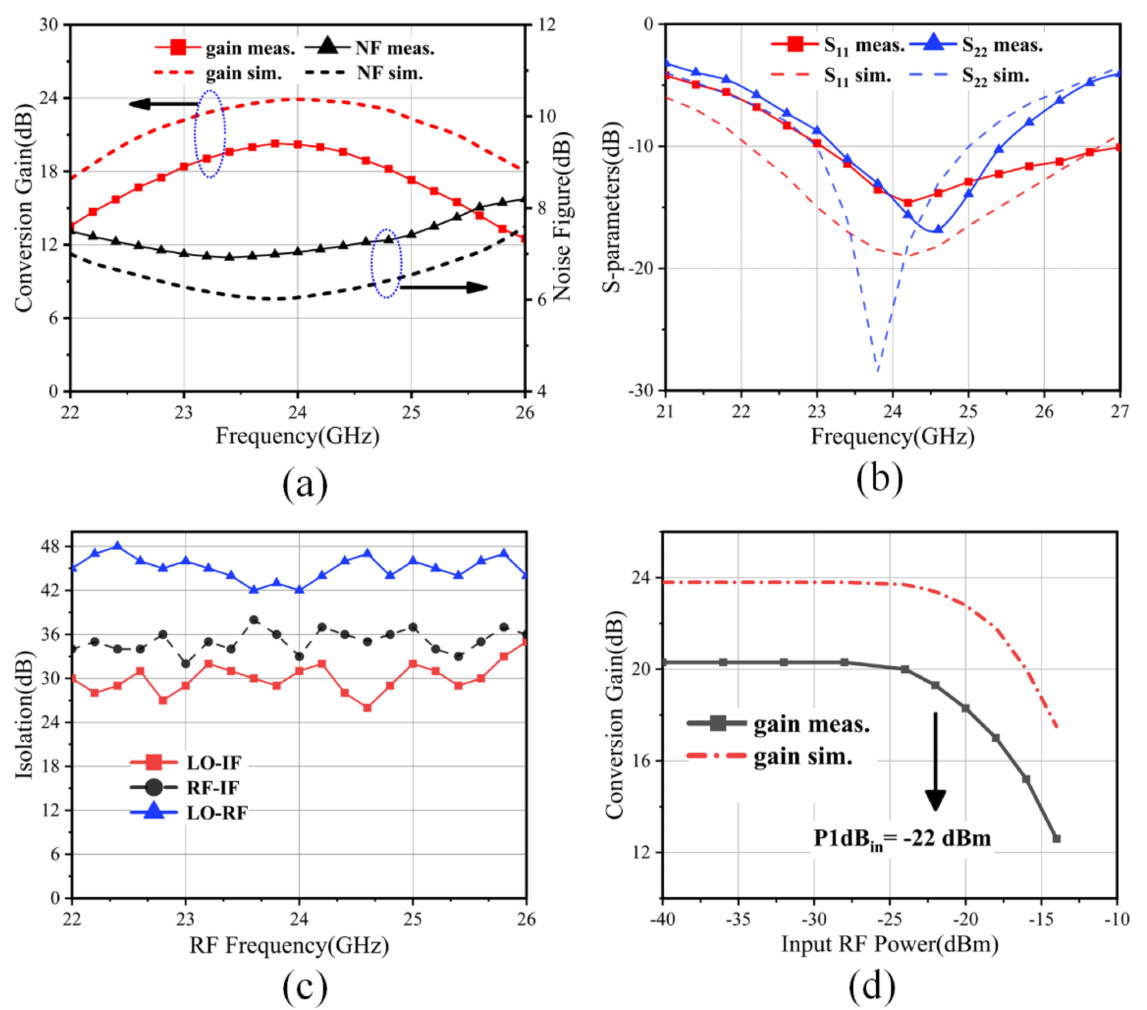
Figure 9. ( a ) Conversion gain and NF (noise figure) of receiver; ( b ) S-parameters of RF (radio frequency) and LO (local oscillator) ports; ( c ) Measured port solation of receiver; ( d ) P 1dB of